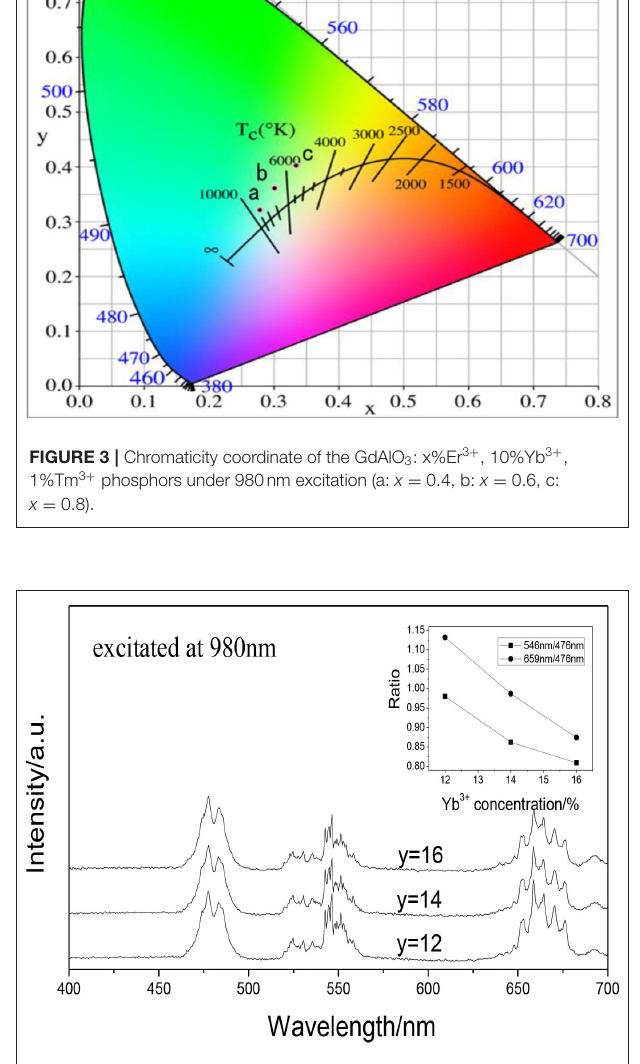
to blue emission shows a downward trend with the increase of Yb 3 + doping concentration. Figure 5 represents the CIE diagram of the phosphors with different Yb 3 + doping concentrations. The CIE are (0.2926, 0.3542), (0.2811, 0.3373), and (0.2725, 0.3272) as shown in the points a, b, and c when the Yb 3 + doping concentration was 0.12, 0.14, and 0.16, respectively. The CIE moves to the blue light direction with the increase of the Yb 3 + doping concentration,